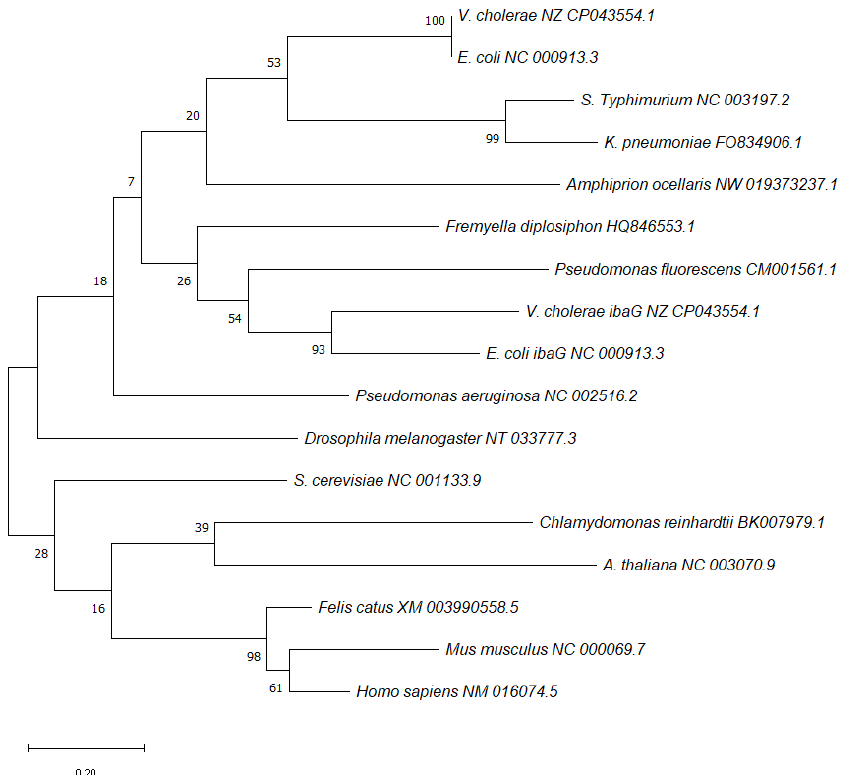
Figure 1. Maximum-likelihood phylogenetic reconstructions of bolA1 using MEGA software v11.0.11 [13]. Distance estimation was obtained by Tamura–Nei model. Numbers at the nodes represent bootstrap values (%) based on 1000 replicates. Gene sequences were aligned using MUSCLE and the trees were reconstructed using default settings. The sequences of each gene were obtained from NCBI database [12] and the GenBank accession numbers are written next to each species.